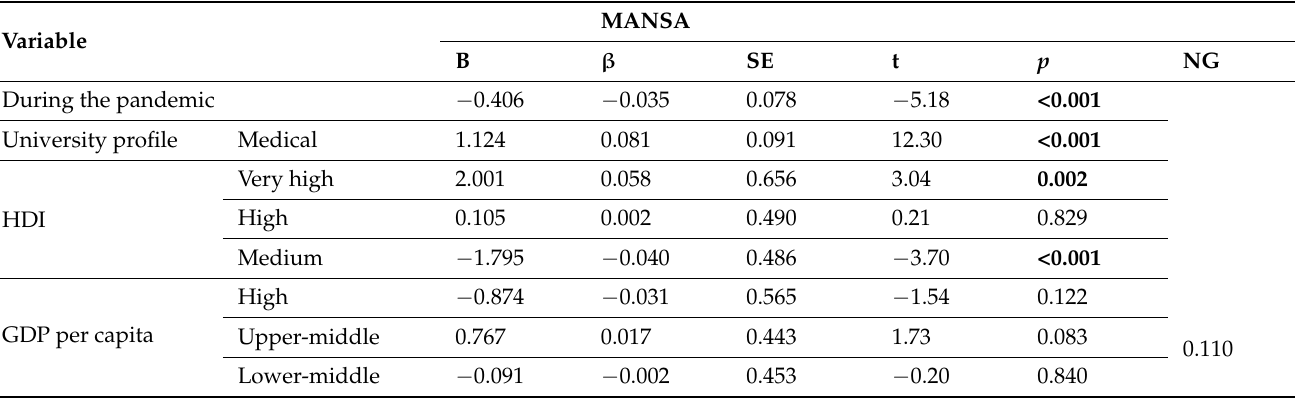
Table 3. The effects of sociodemographic variables, pandemic, university profile, year of study, insomnia, and daytime sleepiness on the subjective AQoL in a complex backward stepwise linear regression